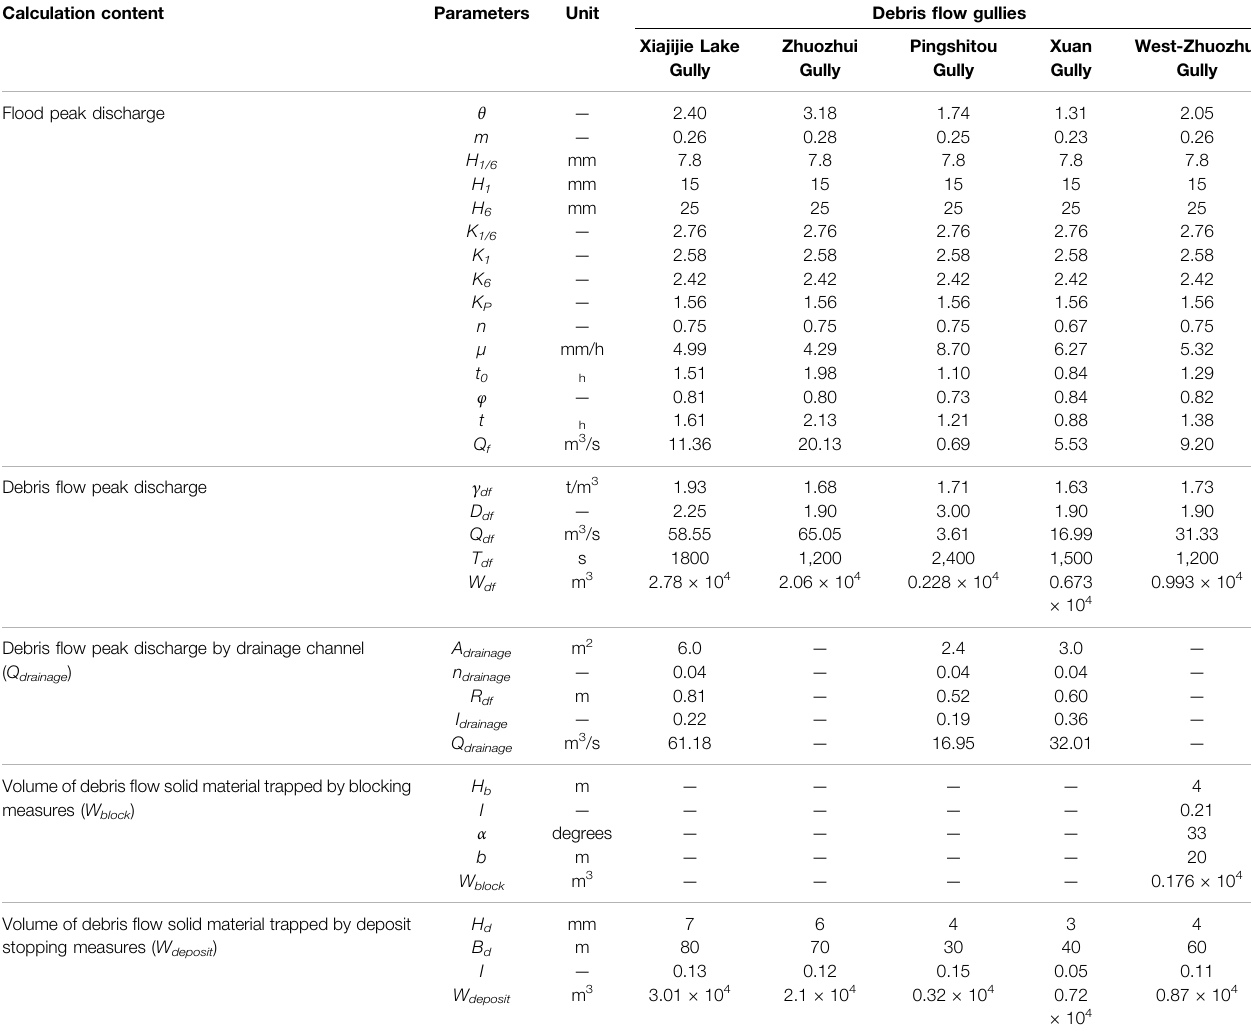
TABLE 3 | Parameter calculation results using the method in Engineering Planning Method for Debris Flow Disasters in Scenic Areas section. Calculation